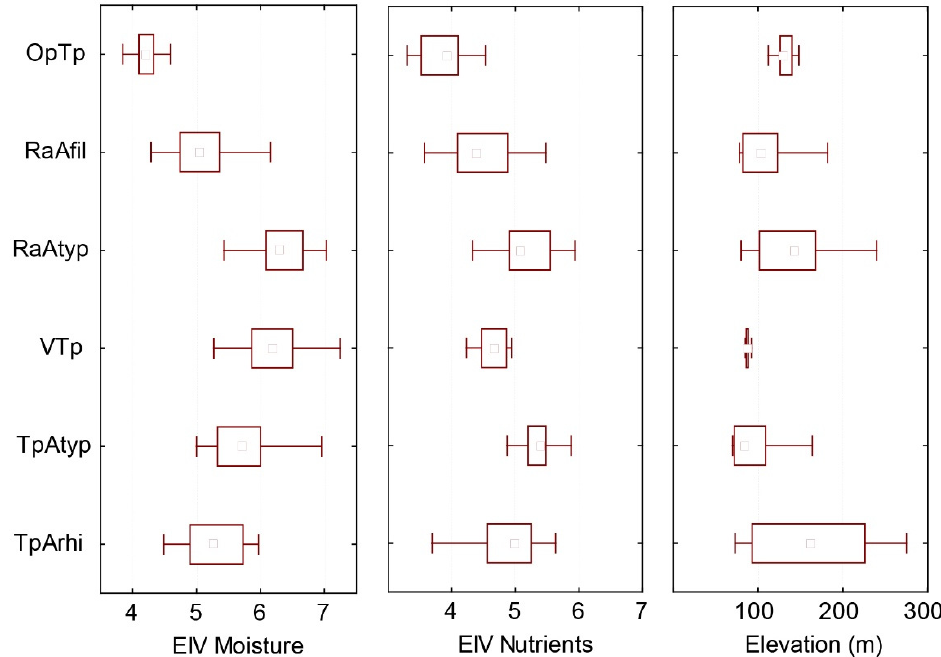
Figure 3. The box–whisker diagram of Ellenberg indicator values (EIV) bioindicator values for moisture and nutrients and altitude (elevation): EIV moisture, EIV nutrients, and elevation. Boxes show the 25–75% quartile range and median value; whiskers indicate the range of values, except outliers. Legend: OpTp— Ornithogalo – Trifolietum , RaAfil— Ranunculo–Alopecuretum filipenduletosum , RaAtyp— Ranunculo–Alopecuretum typicum , VTp— Ventenato–Trifolietum , TpAtyp— Trifolio – Alopecuretum typicum , TpArhi— Trifolio – Alopecuretum rhinanthetosum .